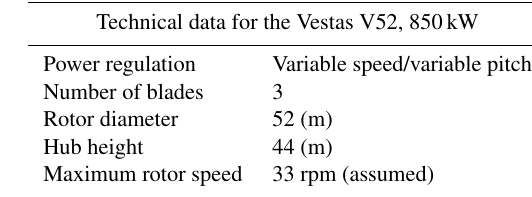
Table 3. Data for the Vestas V52 wind